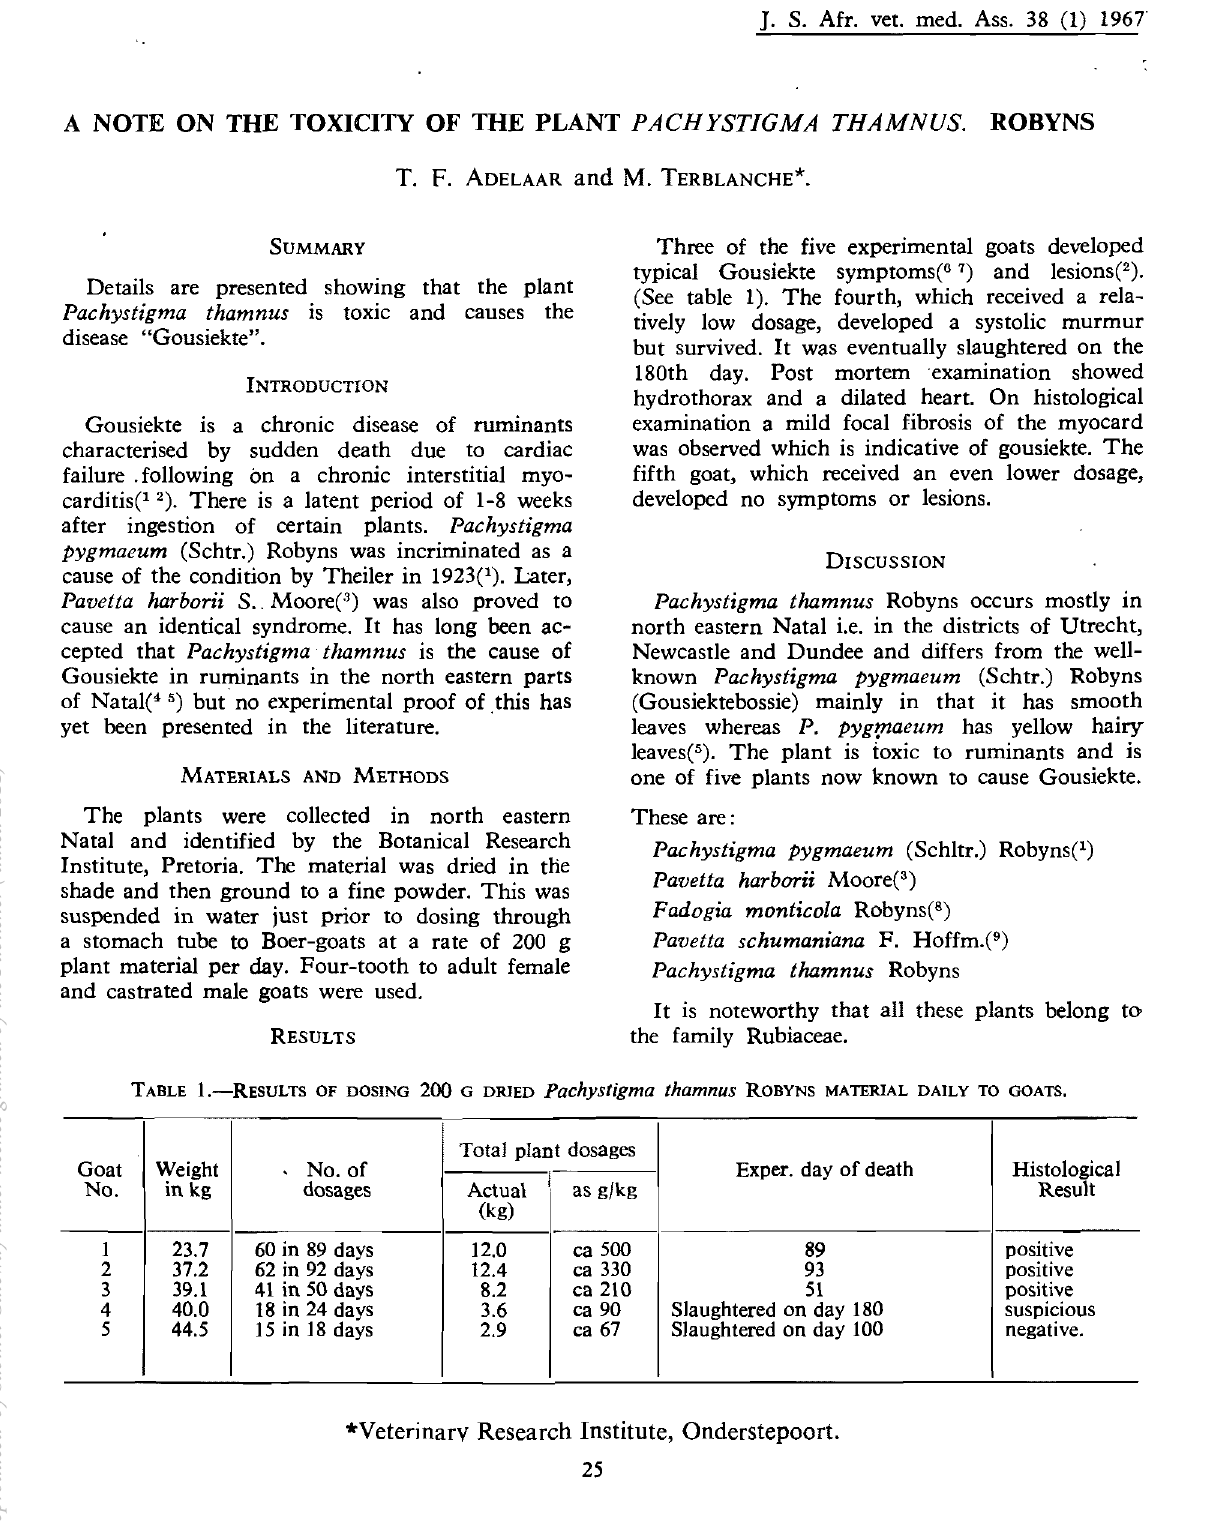
TABLE I.-RESULTS OF DOSING 200 G DRIED Pachystigma thamnus ROBYNS MATERIAL DAILY TO GOATS.